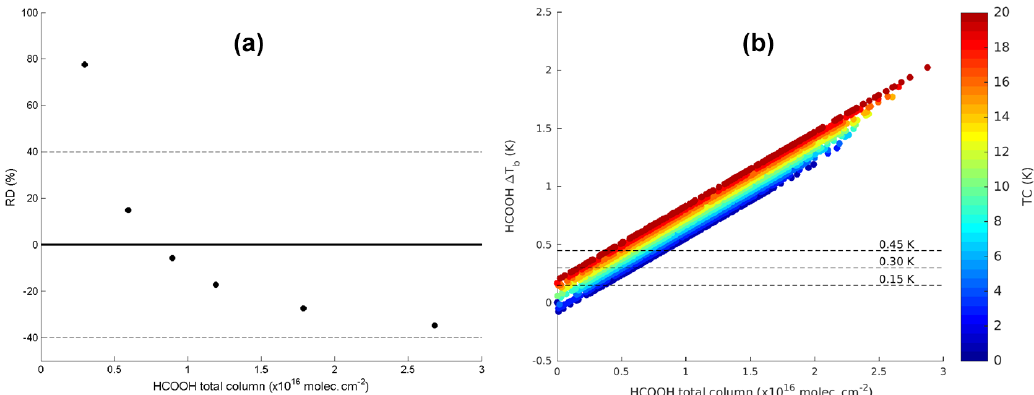
Figure 6. (a) Variation of the mean relative difference between the total columns derived from the (cid:49)T b conversion and the a priori total columns (used as input in the forward simulations) according to the a priori used. The black solid line corresponds to a relative difference equal to 0 and the dashed black lines to ± 40%. (b) Variation of the simulated (cid:49)T b for different HCOOH total columns and TC. The dashed black lines correspond to a (cid:49)T b equal to 0.15, 0.30, and 0.45K; 0.15K corresponds to the IASI radiometric noise in the HCOOH spectral range (see Sect. 2.1).